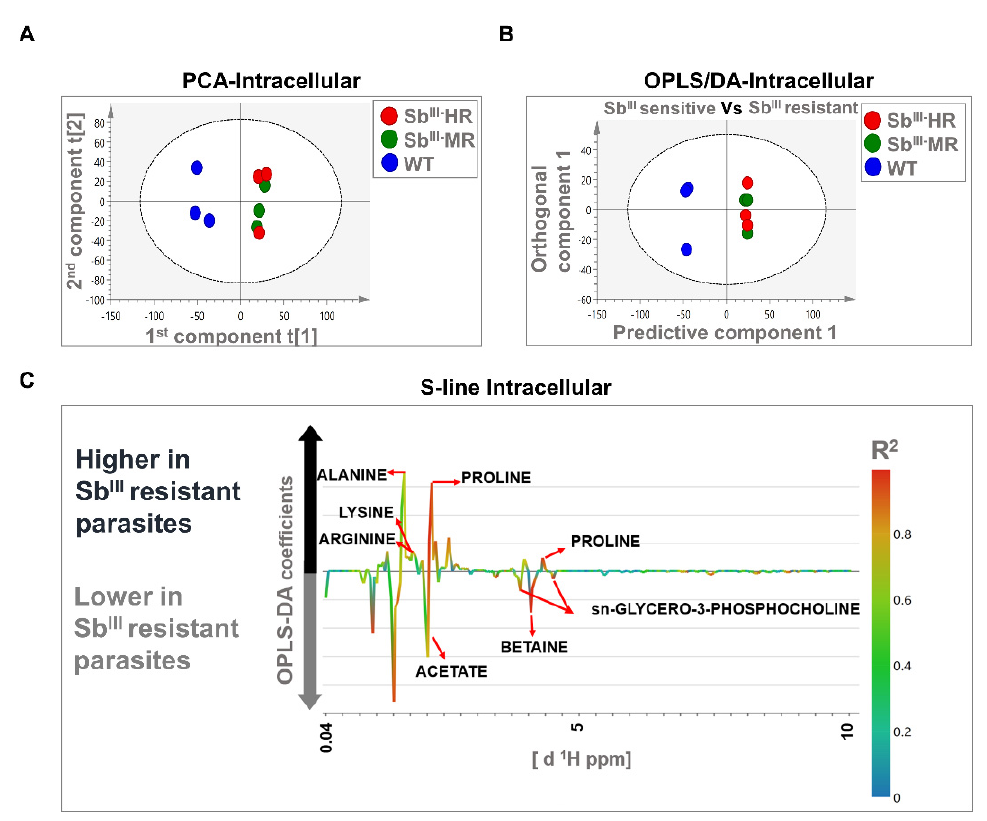
Figure 4. Multivariate analysis showing significant differences between the metabolomic profiles of sensitive and resistant Leishmania parasites at the intracellular level by 1 H-NMR. ( A ) Score plot of PCA. ( B ) OPLS-DA score plot comparing antimony-resistant vs. antimony-sensitive parasites. ( C ) S-line plot highlighting the metabolites with major contributions to group separation. Each individual dot in panel ( A ) or ( B ) represents an observation or sample. Some dots can be overlapped. Blue dots: WT strain; green dots: MR strain; red dots: HR strain. The dotted ellipse of score plots describe the 95% confidence interval of the Hotelling’s T-squared distribution. The color bar in the S-line plot corresponds to the absolute value of the correlation loading in the discrimination model. A total of 9 observations are shown distributed in 3 independent biological replicates per experimental condition (WT, MR, and HR).